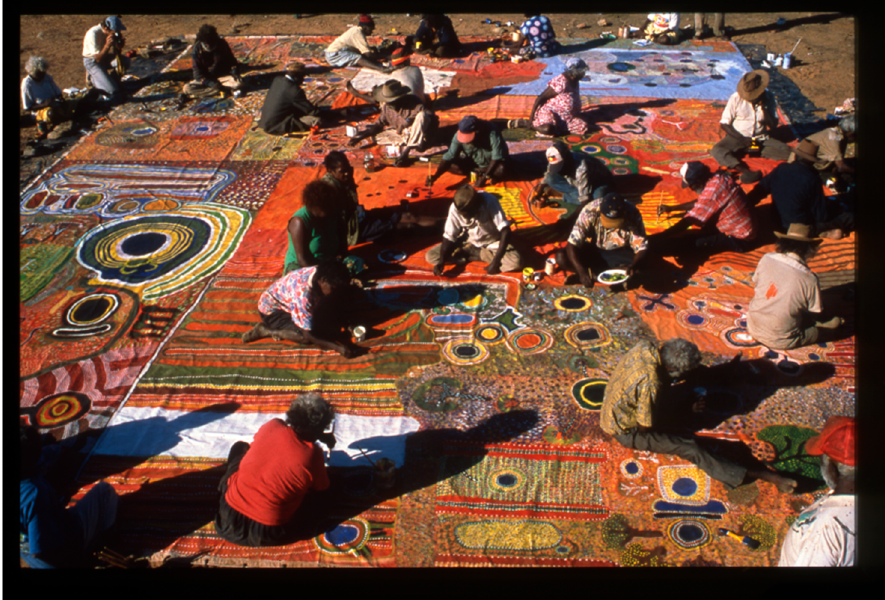
Figure 1. Ngurrara artists painting Ngurrara Canvas II at Pirnini Great Sandy Desert, May 1997. Photography K. Dayman (Used with permission from Ngurrara Artists and Mangkaja Arts Resource Agency). Copyright Ngurrara Artists and Mangkaja Arts Resource Agency.